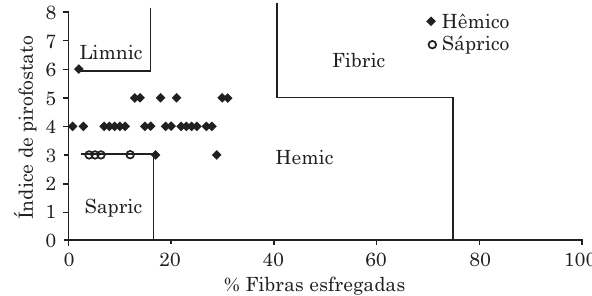
Figura 5. Classificação do material orgânico, segundo a relação entre método químico (índice de pirofosfato) e método físico (teor de fibras esfregadas).